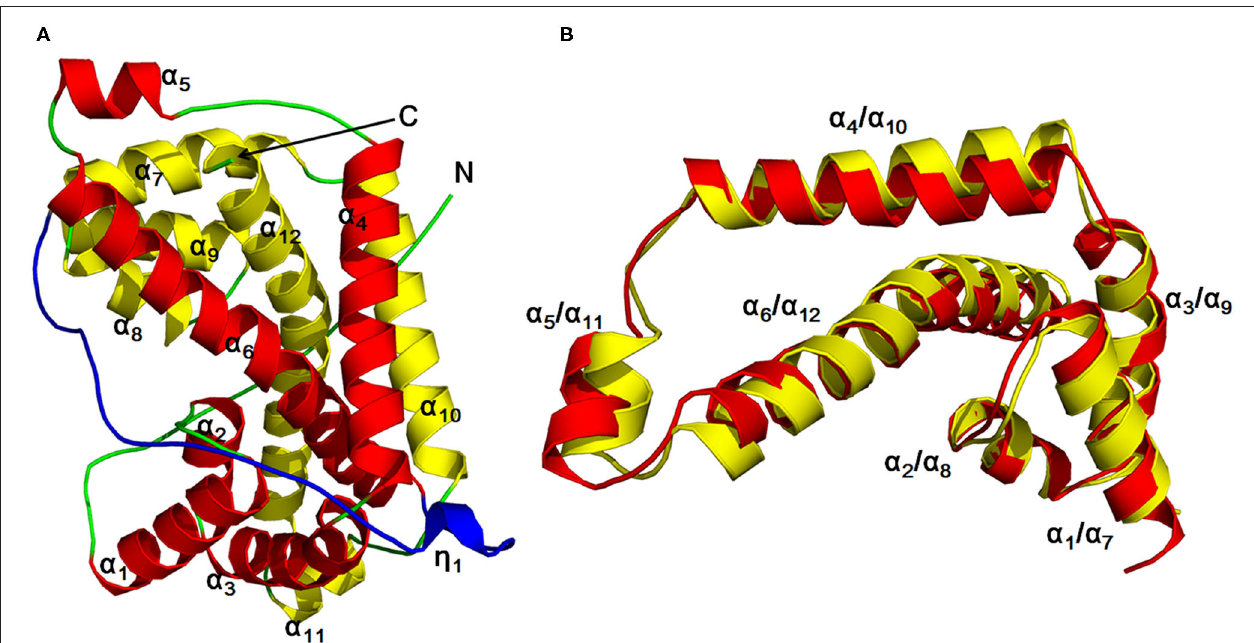
FIGURE 6 | HadD AJ1 monomer (Wang et al., 2018). (A) Ribbon representation of monomeric HadD AJ1 composed of two repeats (repeat 1: red; repeat 2: yellow) and a linker (cyan). (B) 3D superposition of repeat 1 (red) and repeat 2 (yellow).